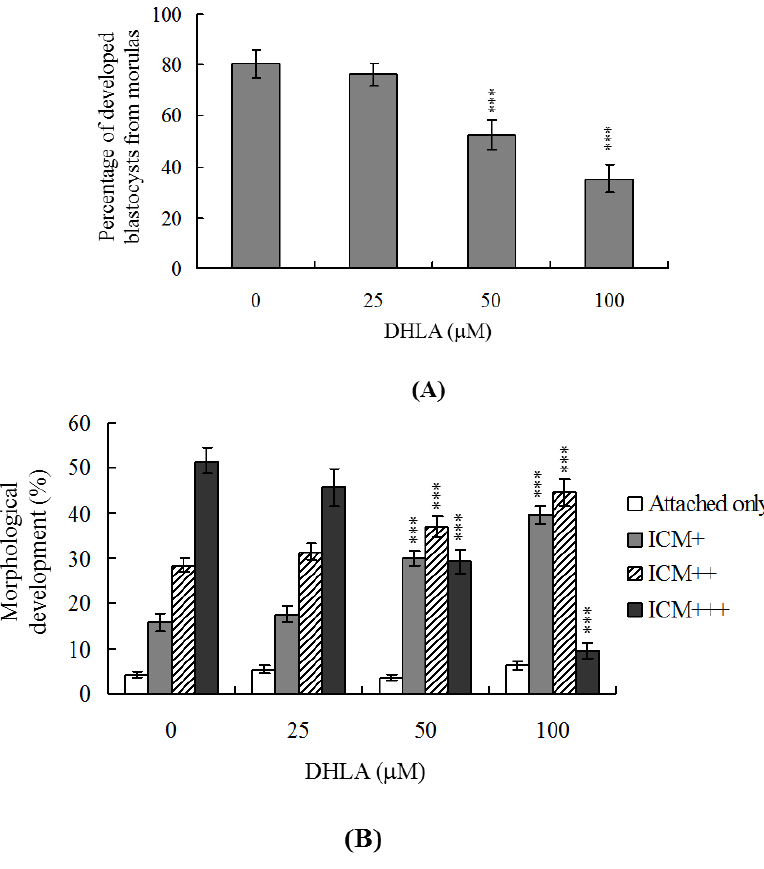
Figure 3. In vitro development of mouse embryos exposed to DHLA at the blastocyst stage. ( A ) Mouse morulae were treated with DHLA (25, 50 or 100 μM) for 24 h or left untreated, and cultured for an additional 24 h at 37 °C. Blastocysts were counted and percentages calculated; ( B ) Mouse blastocysts were treated with DHLA (25, 50 or 100 μM) for 24 h or left untreated and cultured for 7 days post-treatment. Blastocysts were identified as attachment only, ICM(+), ICM(++), and ICM(+++) via morphological assessment, as described in Materials and Methods. Values are presented as means ± SEM of eight determinations. *** P < 0.001 versus the control